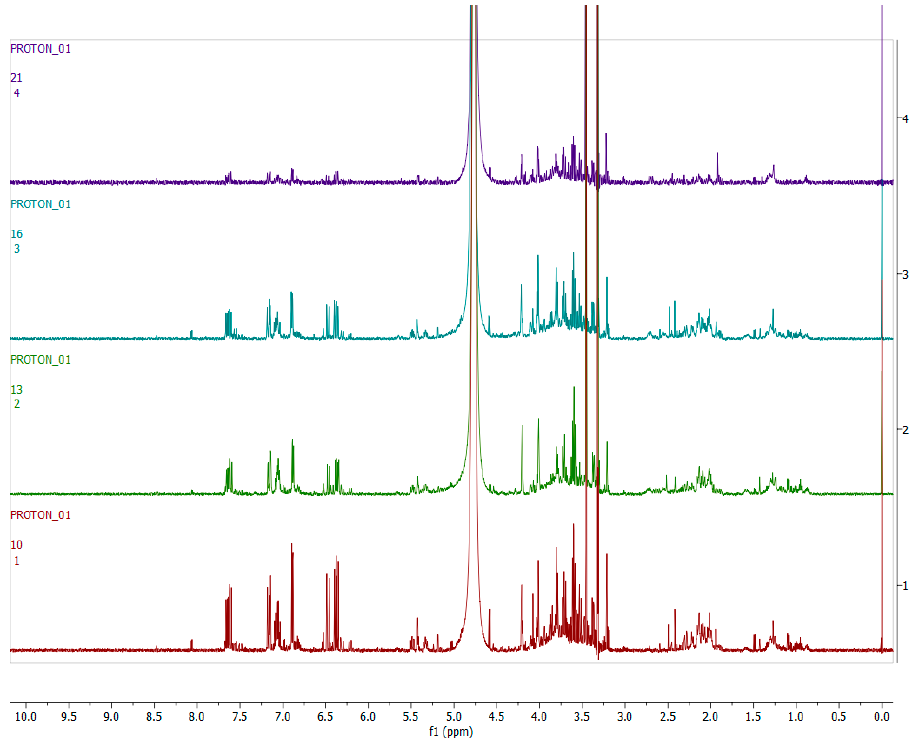
Figure 10. The 600 MHz 1 H-NMR spectra of H. aureonitens leaf extracts collected from the wet and dry sites at Wakefield during spring season. Red =site 1 (wet); green = site 2 (wet); blue = site 3 (wet); purple = site 4 (dry).